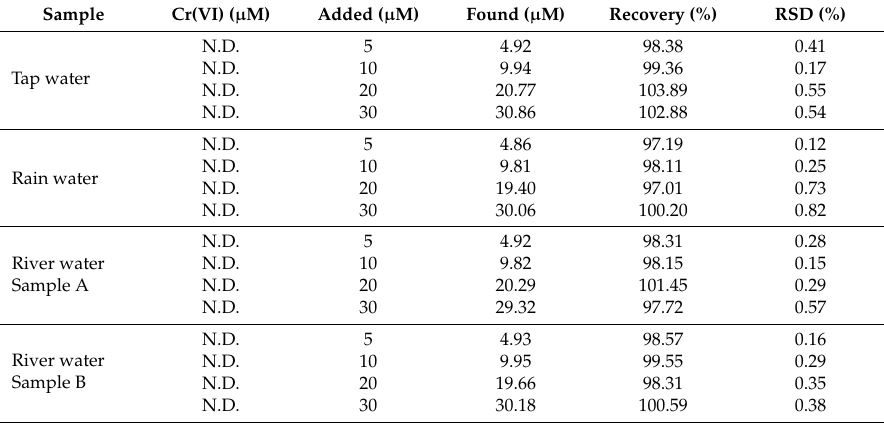
Table 1. Recoveries for the detection of Cr(VI) in water samples ( n = 5).